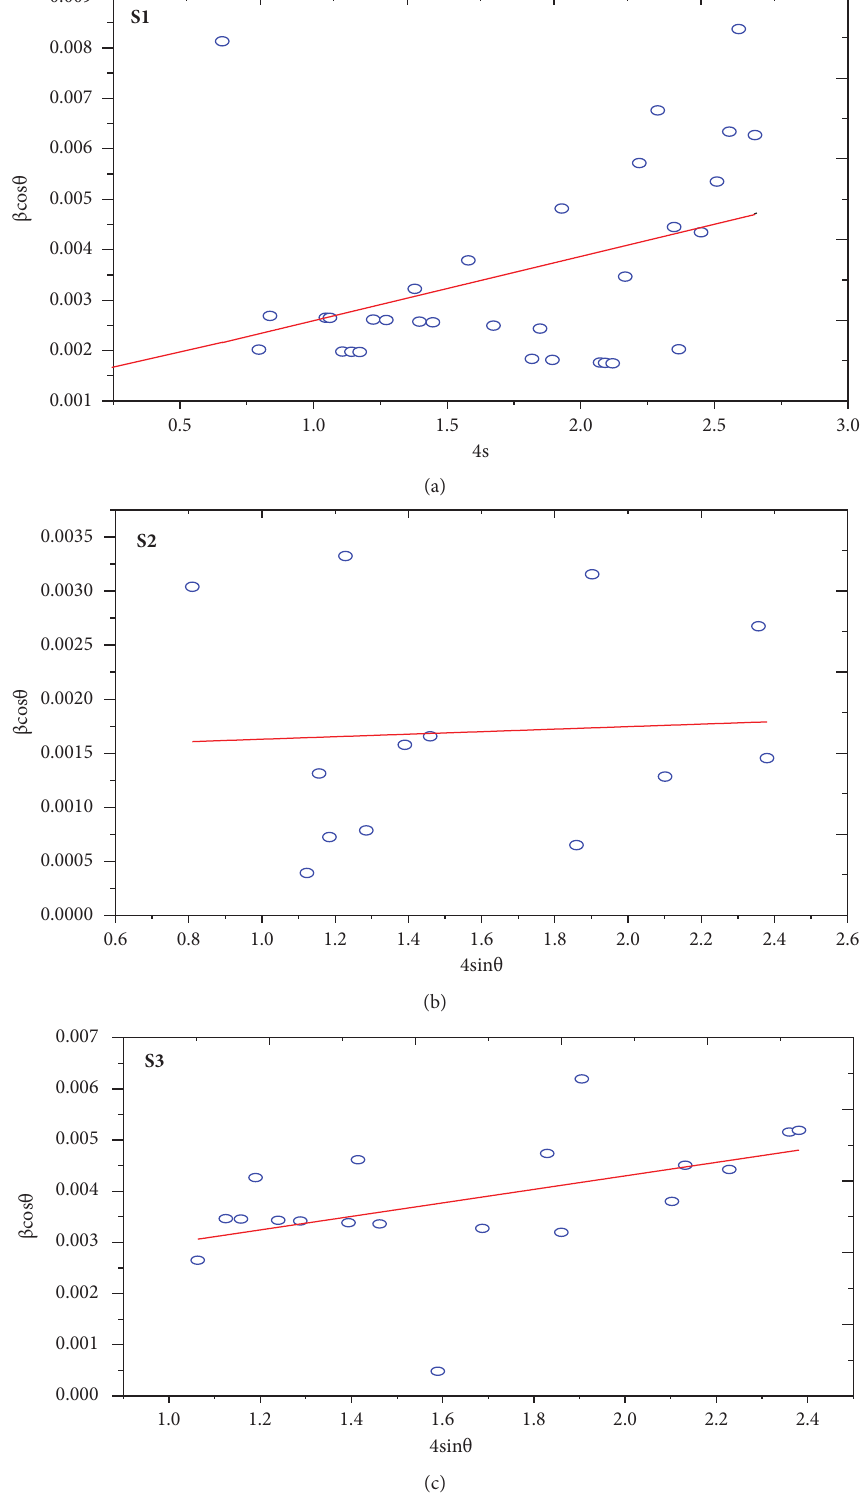
Figure 4: Williamson–Hall Plots for the samples dried at different